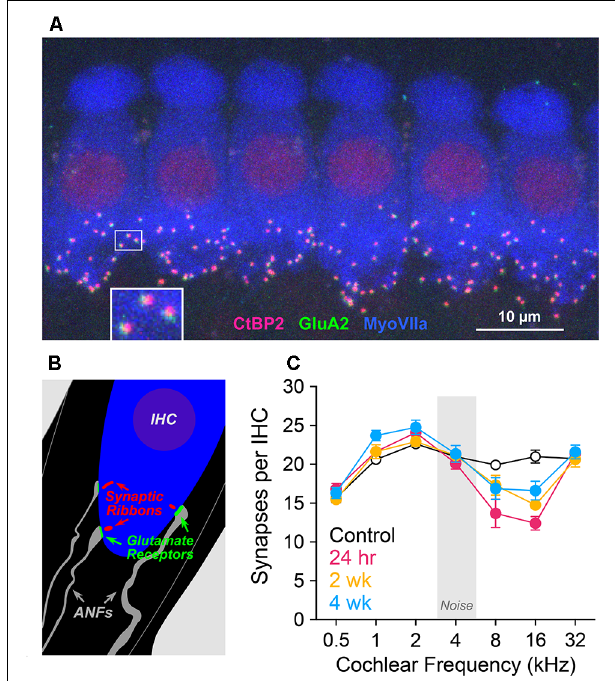
FIGURE 3 | Synapse counts. (A) Confocal maximum projection of six adjacent inner hair cells (IHCs) in the 2 kHz cochlear location, immunolabeled for presynaptic ribbons (CtBP2, red), postsynaptic receptor patches (GluA2, green), and IHCs (myosin VIIa, blue). At the base of one hair cell, a small white rectangle indicates the region displayed below at higher magnification. (B) Schematic of the IHC area showing presynaptic and postsynaptic elements. (C) Synapses per IHC at cochlear locations corresponding to CAP test frequencies, plotted as group means ± SEM in unexposed and exposed gerbils 24 h, 2 wk, and 4 wk after noise, n = 4 animals/group. ANOVA models were run at 8 and 16 kHz using hierarchical tests at each frequency in a predefined sequence. Comparison of control vs. all exposed groups (alpha = 0.05) indicated a significant effect of exposure at both 8 kHz ( p = 0.02) and 16 kHz ( p < 0.001). At 8 kHz, 24 h vs. 2 wk, 4 wk (alpha = 0.025) was not significant ( p = 0.11), nor was control vs. 2 wk, 4 wk ( p = 0.07). At 16 kHz, 24 h vs. 2 wk, 4 wk (alpha = 0.025) was significant ( p = 0.005), as was control vs. 2 wk, 4 wk ( p < 0.001). Pairwise comparison of 2 wk vs. 4 wk was not significant at either